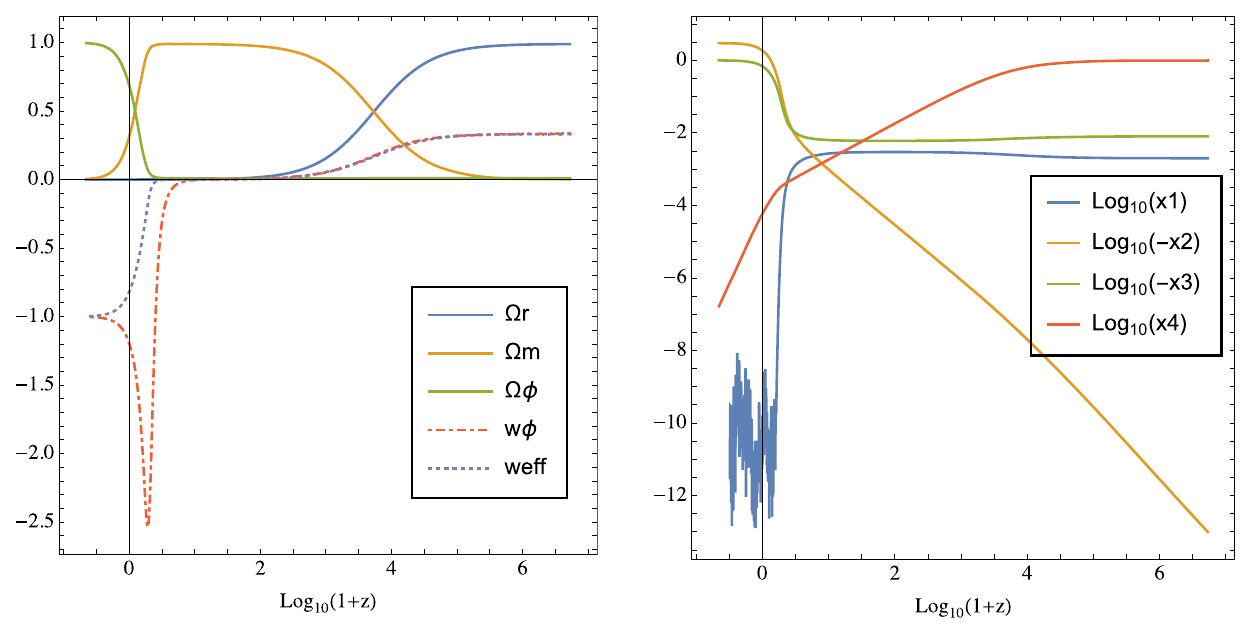
Fig. 1 Theevolutionofthedensityparametersandtheequationofstate parameters where we set x 1 − 0 . 002 = 1 × 10 − 6 , x 2 = − 1 × 10 − 13 , x 3 + 0 . 008 = 1 × 10 − 6 , and x 4 = 0 . 989 at log 10 ( 1 + z ) = 6 . 73